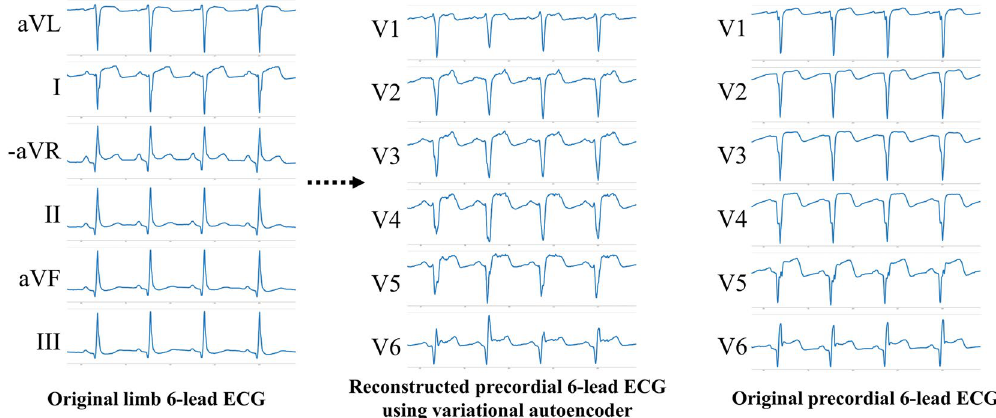
Figure 4. Reconstructed precordial 6-lead ECG using limb 6-lead ECG by auto-encoder and original precordial 6-lead ECG. DLA deep learning-based algorithm, ECG electrocardiography, MI myocardial infarction.